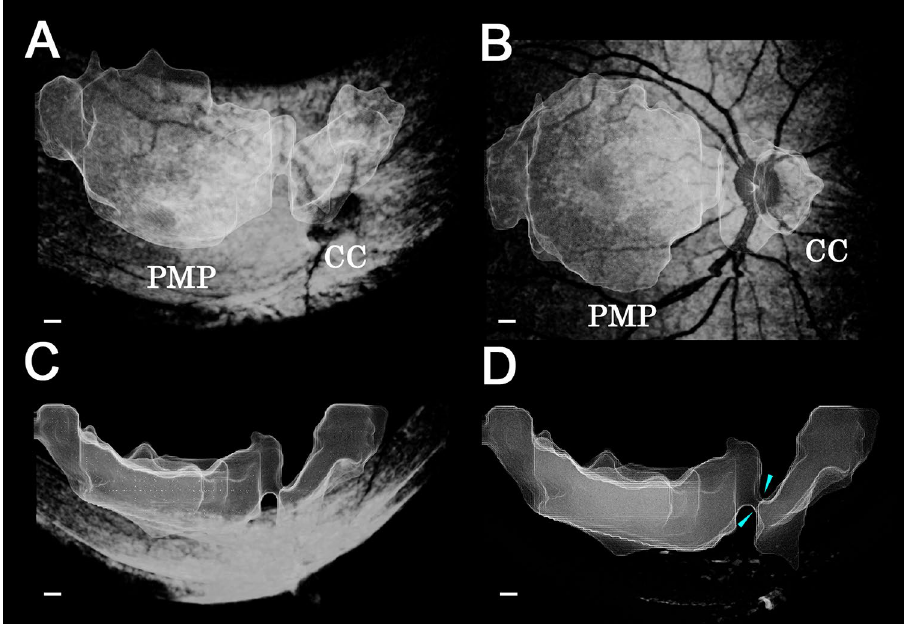
Figure 2. Three-dimensional model of the vitreous cavity of the right eye of a healthy 8-year-old girl. ( A) Top view image from the inferior side of the eye shows that a premacular vitreous pocket (PMP) and Cloquet’s canal (CC) are present above the macular retina and optic disc. ( B) Front view image of the 3D model shows that the PMP extends between the retinal vascular arcade. The volume and surface area of the PMP are 12 ± 1 mm 3 and 75 ± 5 mm 2 respectively. The CC is located anterior to the optic disc and the volume and surface area of the CC are 2.3 ± 0.1 mm 3 and 19 ± 1 mm 2 respectively. ( C ) Image viewed from the inferior side shows that the PMP and CC stand on the retinal surface. ( D) Image viewed from the inferior side without the retinal image. Light blue arrowheads show the connection between the PMP and CC. The scale bar is 500 µm. Plus-minus values are the propagating error of the segmentation. PMP premacular vitreous pocket, CC Cloquet’s